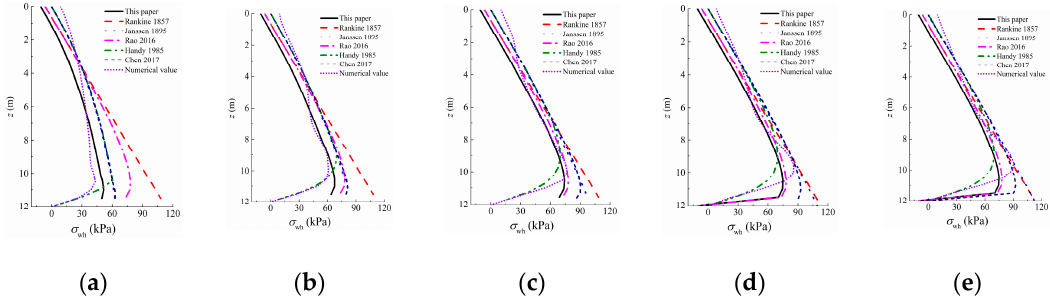
Figure 10. Comparison of the active earth pressure distribution for ( a ) B / h = 0.083; ( b ) B / h = 0.167; ( c ) B / h = 0.333; ( d ) B / h = 0.500; and ( e ) B / h = 0.667.